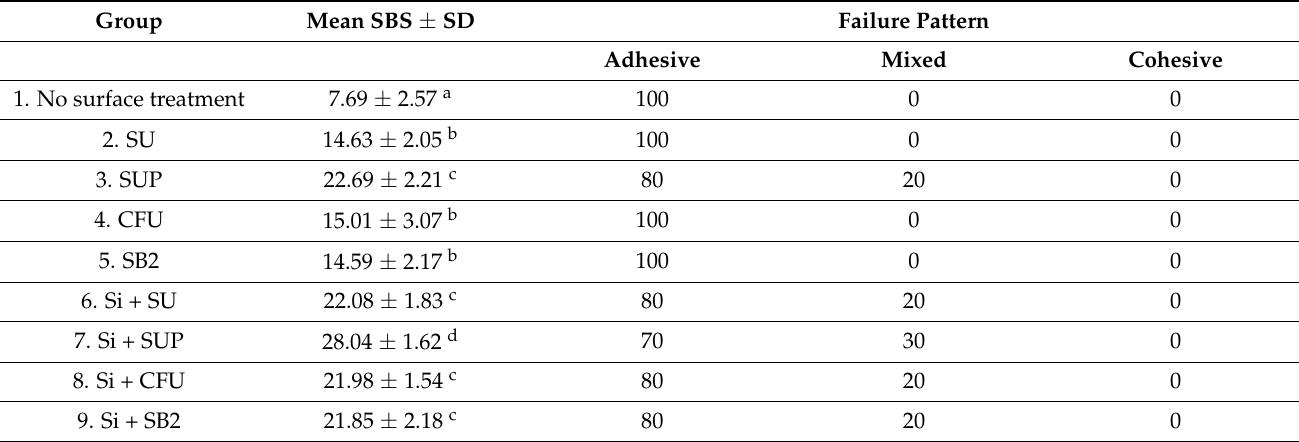
Table 2. The SBS’s means and standard deviation (MPa) and percentage of failure